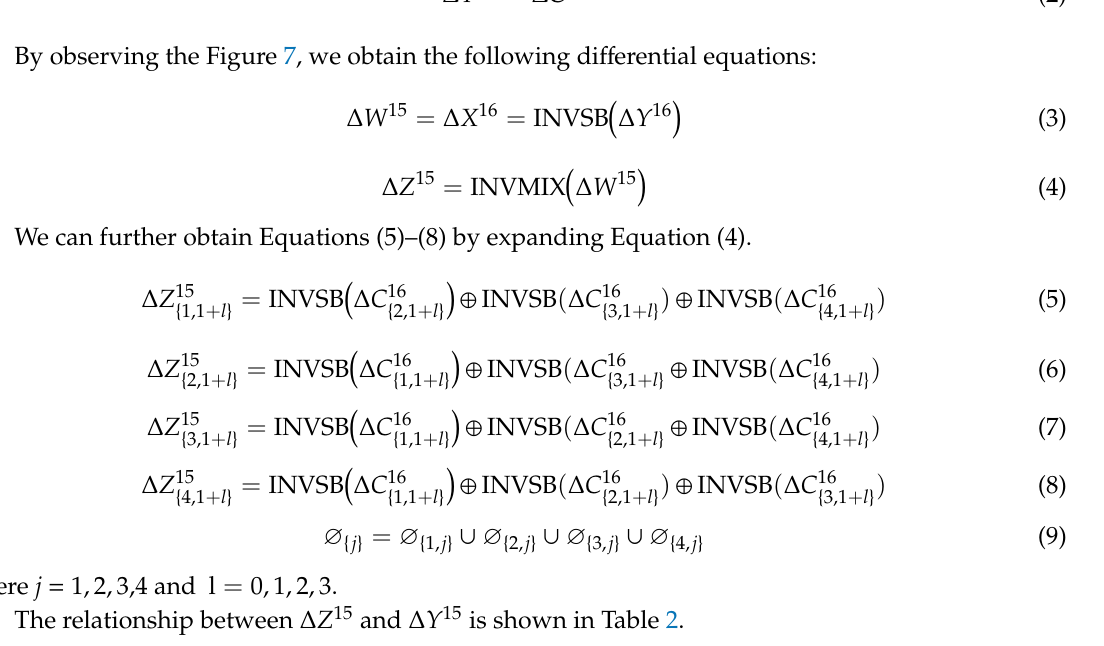
Table 2. The inverse differential of Midori.